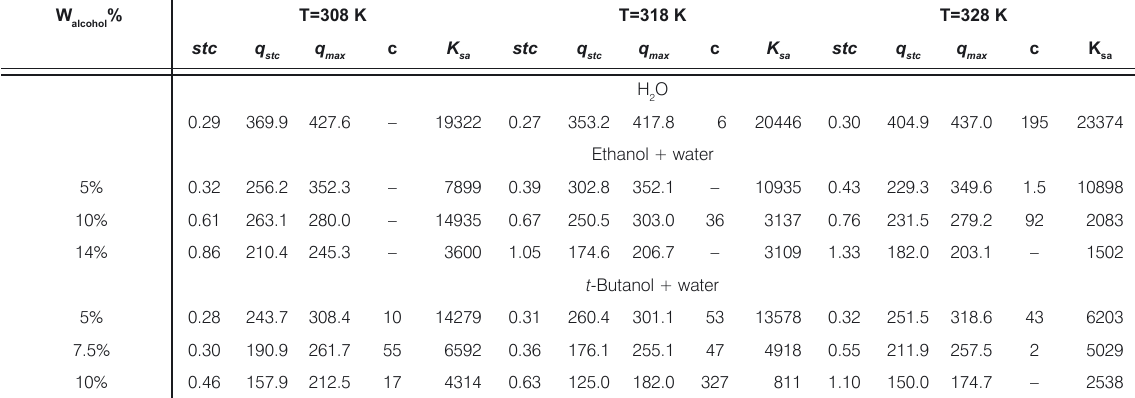
Table 4. Adsorption of TX-100 on silica gel from water and alcohol-water binary mixtures: stc , q 308–328 K.